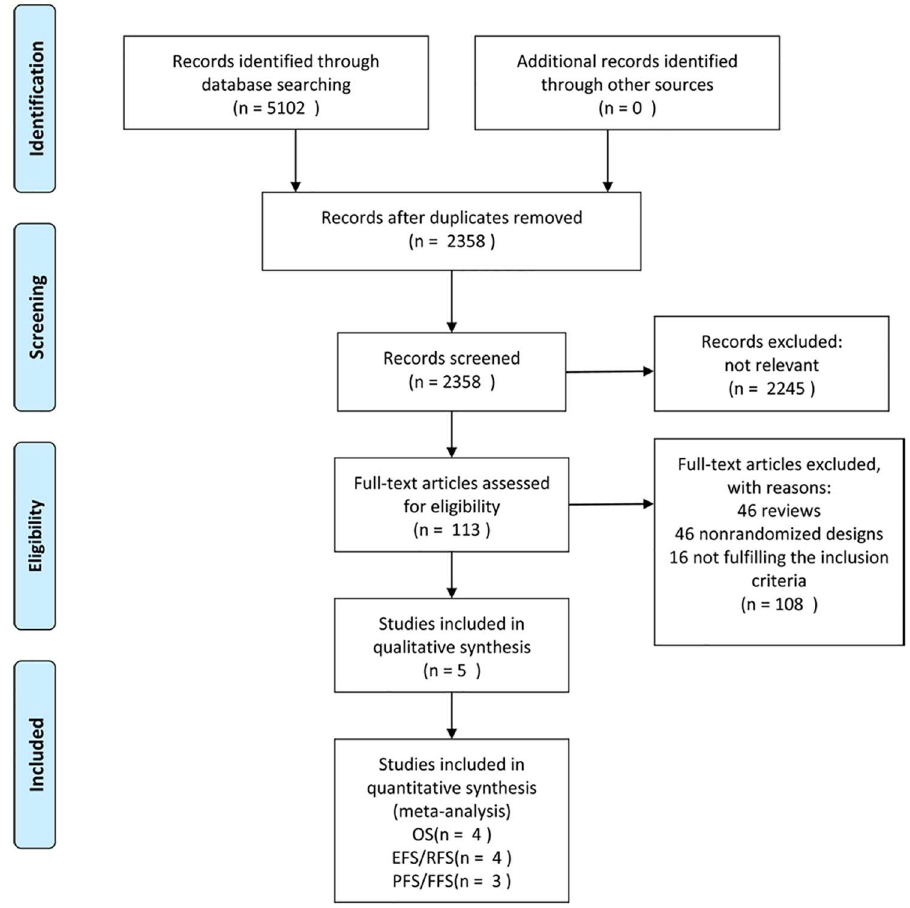
Fig 1. Flowchart of selection of studies for inclusion in meta-analysis.